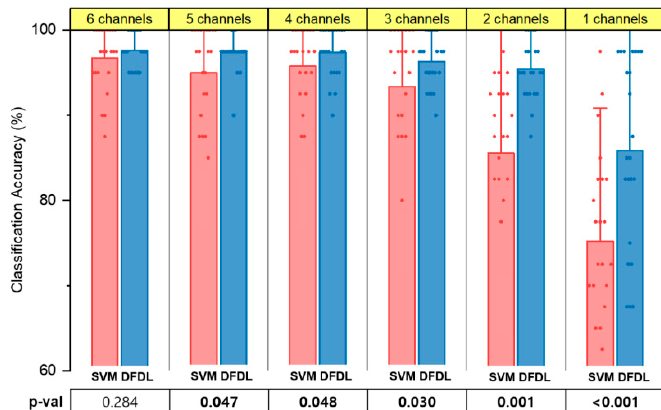
Figure 8. The classification performance of DFDL and SVM_rbf for four essential hand movements using the targeted method. The performance of DFDL was superior to SVM_rbf in every number of channel subsets. Moreover, a decrease in performance was not observed until the number of channels was reduced to 2 in DFDL. Each dot indicates the classification accuracy of each subject. The error bar represents the standard deviation. Bold values indicate significant differences.